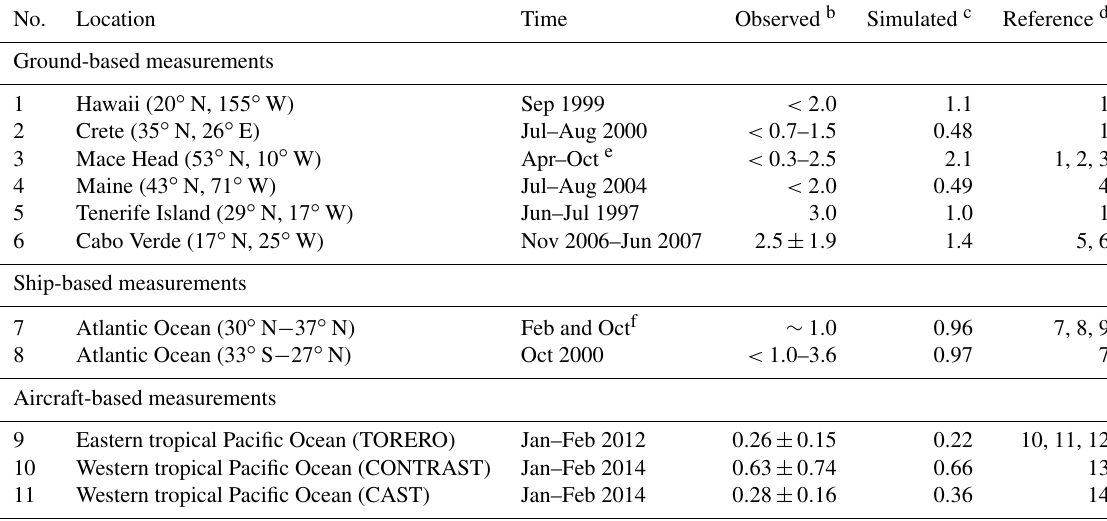
Table 1. Daytime mixing ratios (ppt) of BrO in the marine boundary layer a . No. Location Time Observed b Simulated c Reference d Ground-based